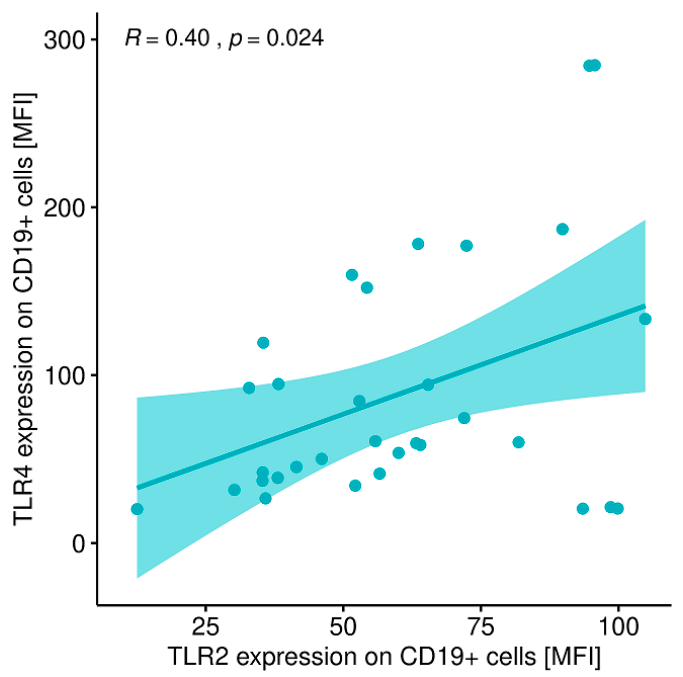
Figure 11. Correlation between the expression level of TLR-2 on CD19+ B lymphocytes (MFI) and the expression level of TLR-4 on CD19+ B lymphocytes (MFI). MFI, mean fluorescence intensity.